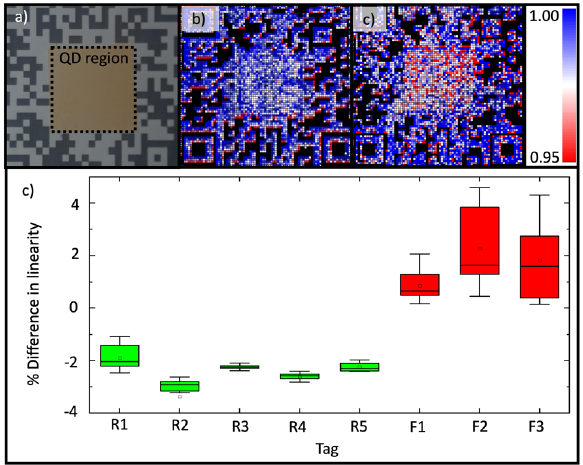
Figure 4. Measuring the non-linear response of a quantum dot-based tag using a smartphone’s camera and flash. ( a ) A smartphone image of a tag comprising a QR Code (black and white outer) surrounding a blank region in the centre that is coated with colloidal quantum dots (CQDs) in a polymer. ( b ) and ( c ) false-colour images showing the exponent extracted from a power fit on the emission-excitation curved measured across the area of a ‘fake’ tag (b) and a ‘real’ tag ( c ). The exponent in the centre of the QD region is lower degree than the surroundings. ( d ) For a series of ‘real’ (R1-5, containing CQDs in the centre region) and ‘fake’ (F1-3, no CQDs) tags, the difference in linearity is plotted, with whiskers on the boxes spanning two standard